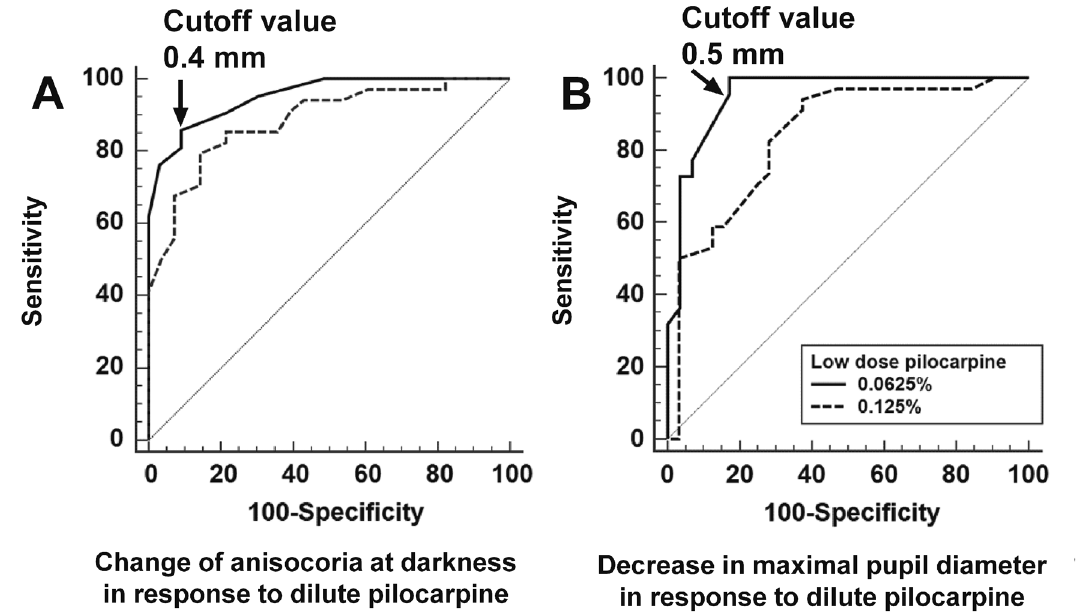
Figure 3. Comparison of the diagnostic ability of two concentrations of dilute pilocarpine for detecting unilateral Adie’s tonic pupil. ( A ) The area under the curve (AUC) of the change in anisocoria at darkness in response to pilocarpine instillation was 0.884 (95% confidence interval [CI], 0.778–0.952) in the 0.125% group and 0.952 (95% CI, 0.857–0.992) in the 0.0625% group ( P = 0.168). In the 0.0625% group, a change in anisocoria ≧ 0.4 mm after topical pilocarpine instillation showed a sensitivity of 85.7% and a specificity of 90.9% for detecting unilateral Adie’s tonic pupil. ( B ) The AUC of the decrease in maximal pupil diameter in response to pilocarpine instillation was 0.840 (95% CI, 0.729–0.919) in the 0.125% group and 0.954 (95% CI, 0.855–0.993) in the 0.0625% group. The diagnostic efficacy of dilute pilocarpine for detecting unilateral Adie’s tonic pupil using a 0.0625% concentration was better than using a 0.125% concentration ( P = 0.047), with a cutoff value of ≧ 0.5 mm pupillary constriction after pilocarpine